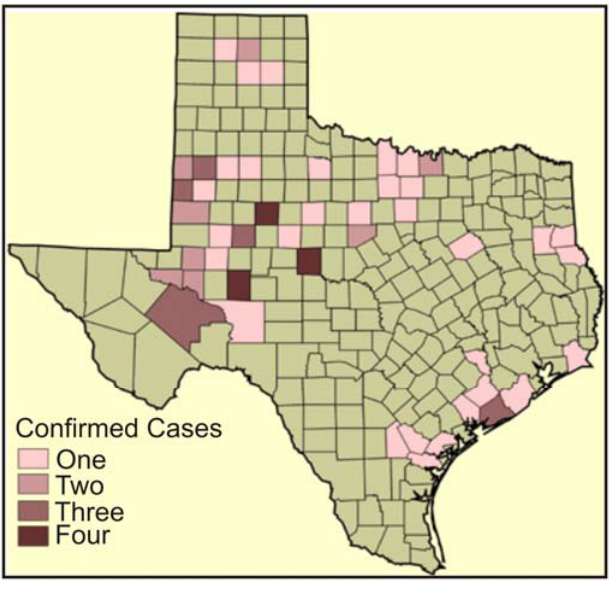
Figure 14. Texas Counties with Cases of Underground Water Pollution Due to Oil and Gas